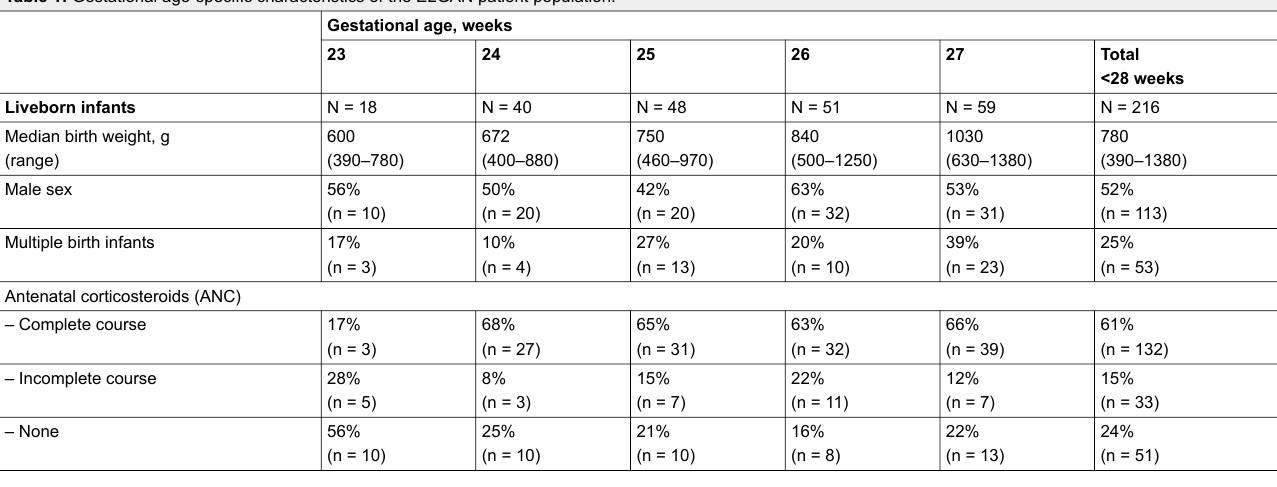
Table 1: Gestational age-specific characteristics of the ELGAN patient population. Gestational age, weeks